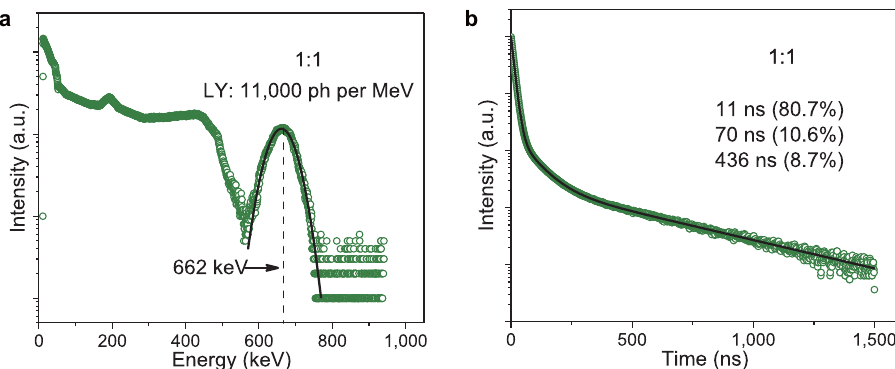
Fig. 4 Gamma-ray excitation characterizations. a Gamma-ray pulse-height spectra and b gamma-ray excited decay of 1:1 Li-(PEA) 2 PbBr 4 . Black line in ( a ) is the Gaussian fi tting for extraction of light yield and energy resolution and in ( b ) is the three-component exponential decay fi